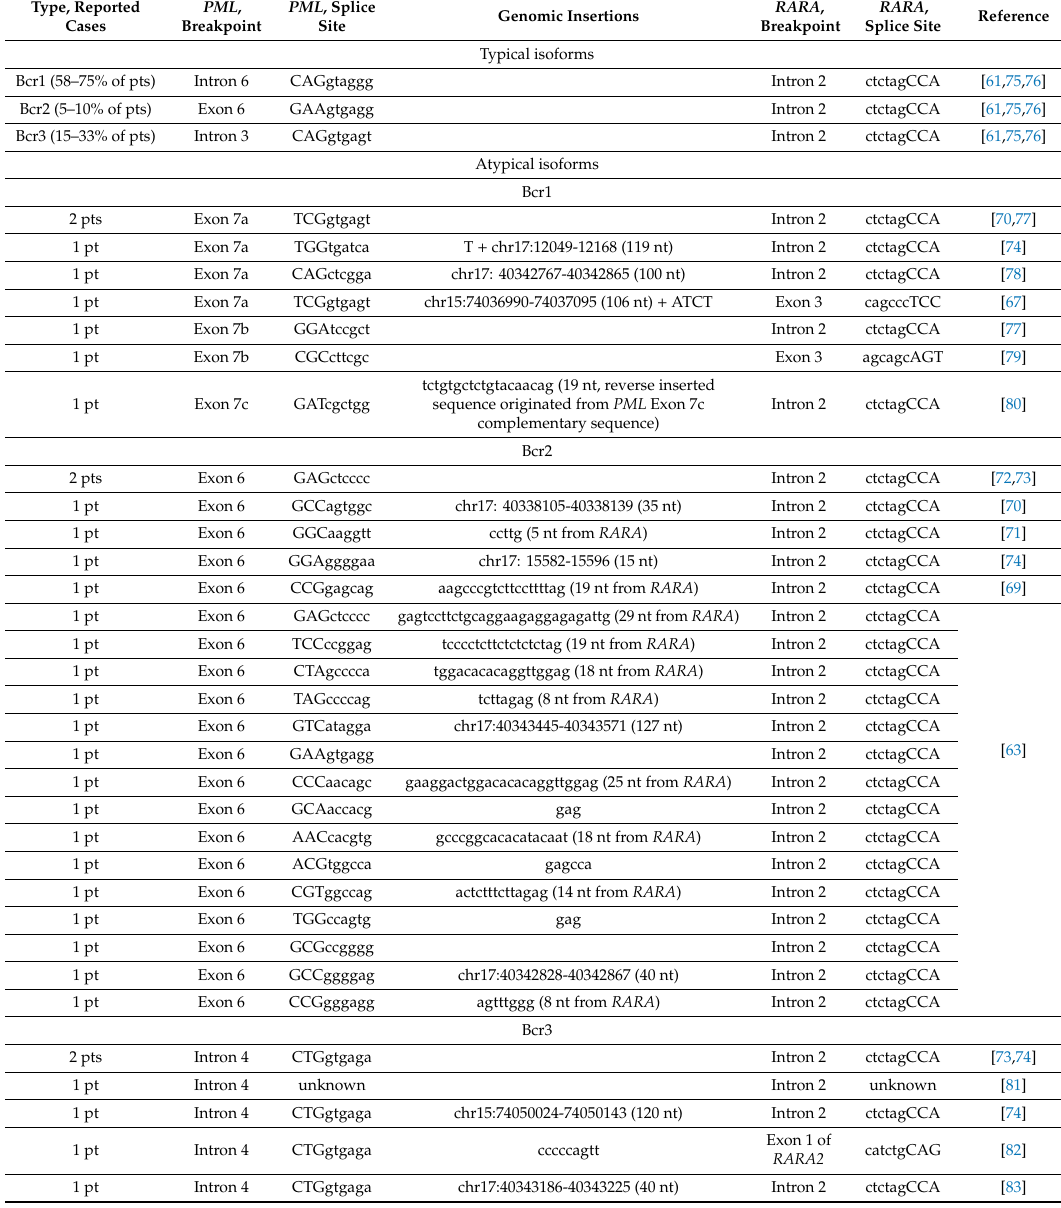
Table 1. Molecular features of typical and atypical PML-RARA